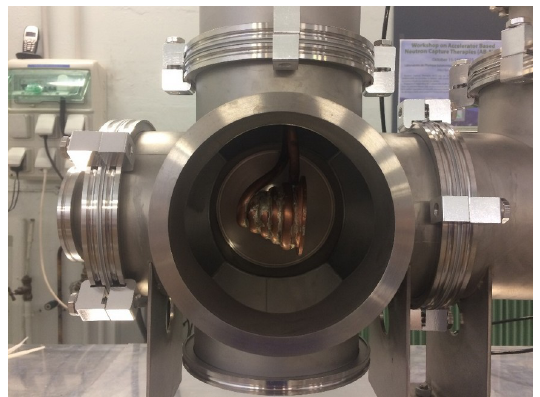
Fig. 7. The Faraday